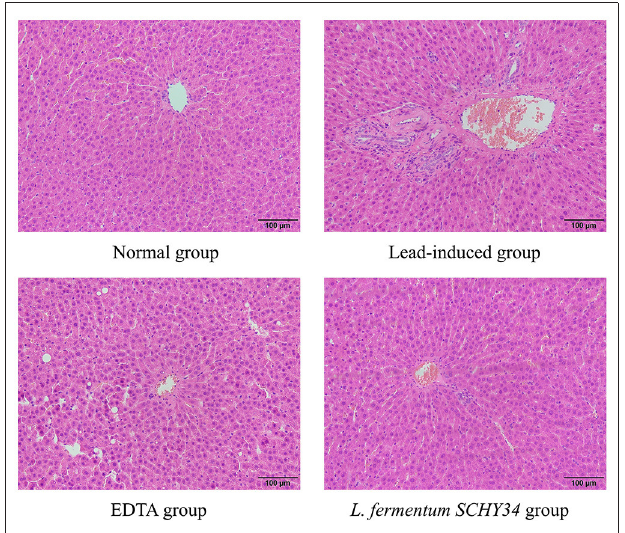
FIGURE 3 | Pathological observation of kidney tissue in SD rats (H&E).